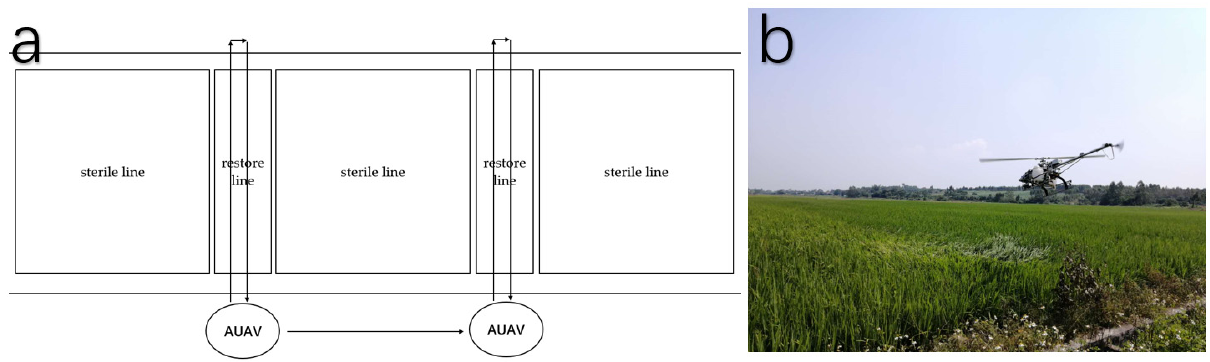
Figure 1. Mechanized hybrid rice seed production with unmanned aerial vehicles at pollination. ( a ): The flight path of the AUAV for assisting pollination; ( b ): the photograph of the AUAV during assisting pollination.